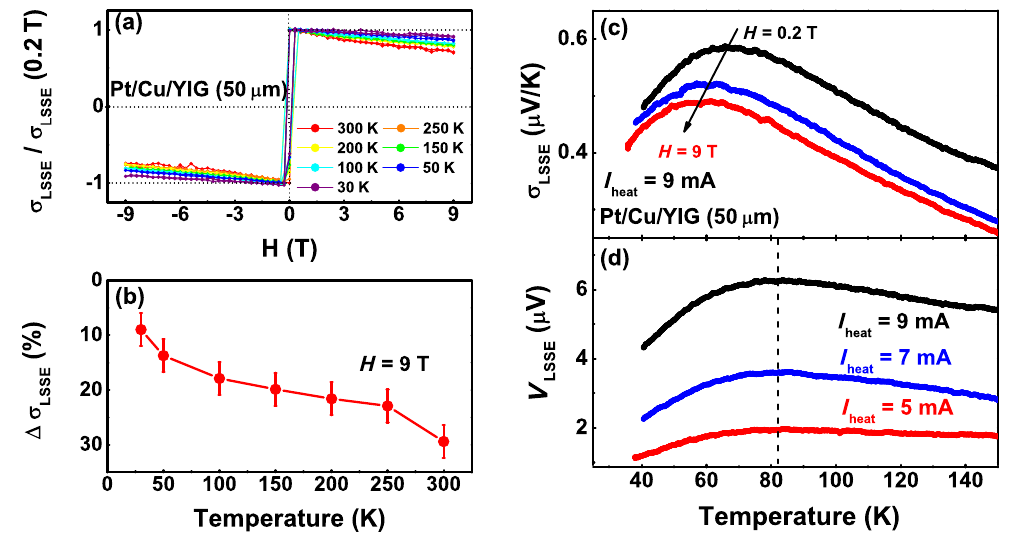
FIG. 3. (a) Magnetic field-dependent normalized LSSE signals of Pt/Cu/YIG hybrids at various temperatures from 30 K to room temperature. (b) Temperature-dependent field suppression ratio of Pt/Cu/YIG hybrids at 9 T. (c) Temperature-dependent σ YIG hybrids measured at a fixed heating power and varied magnetic fields from 0.2 to 9 T. (d) Temperature-dependent LSSE voltages of Pt/Cu/YIG hybrids with a fixed magnetic field of (cid:3) 0 . 2 T and different heating